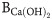
FTIR spectra of (a) BCa(OH)2, and (b) C400,1 and C400,4.